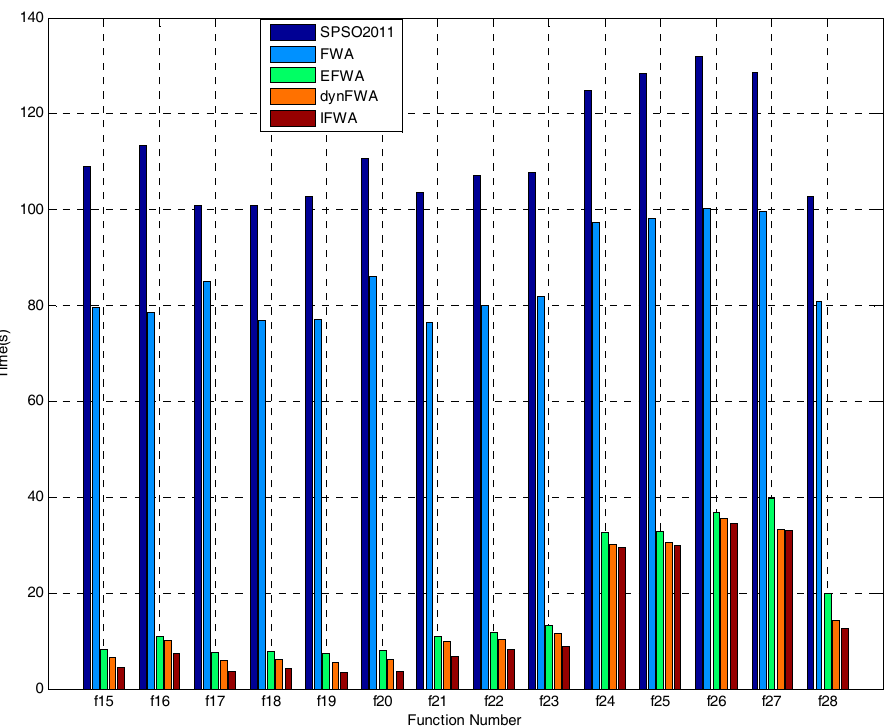
Figure 4. The FWA, EFWA, dynFWA, SPSO2011 and IFWA run-time cost (Continued).